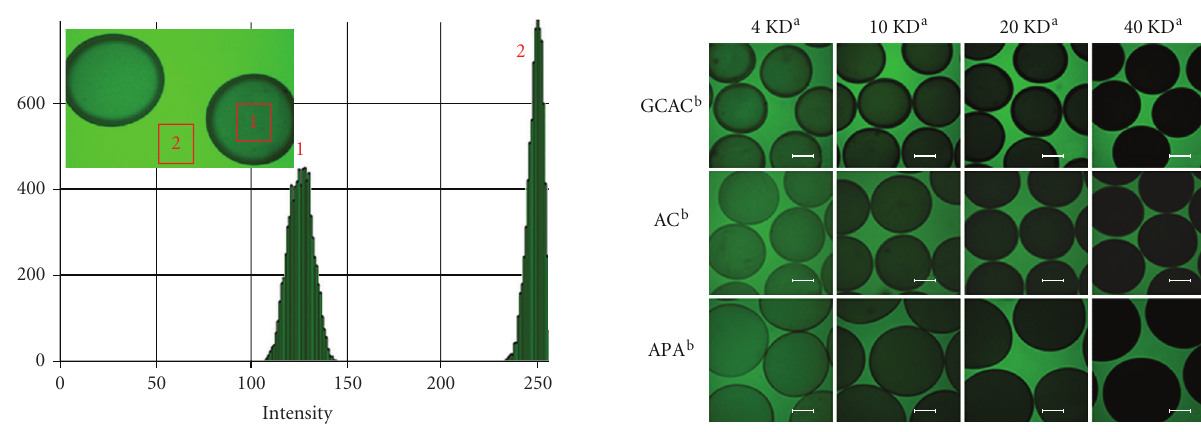
Figure 8: Analysis of fluorescence intensity inside and outside the microcapsule incubated in the solution of a fluorescent marker (20KD FITC-dextran, 0.5 mg/mL). Peak 1 and Peak 2 in the intensity profile correspond to the fluorescence intensity inside (square 1) and outside (square 2) the microcapsule outlined in the insert, respectively.